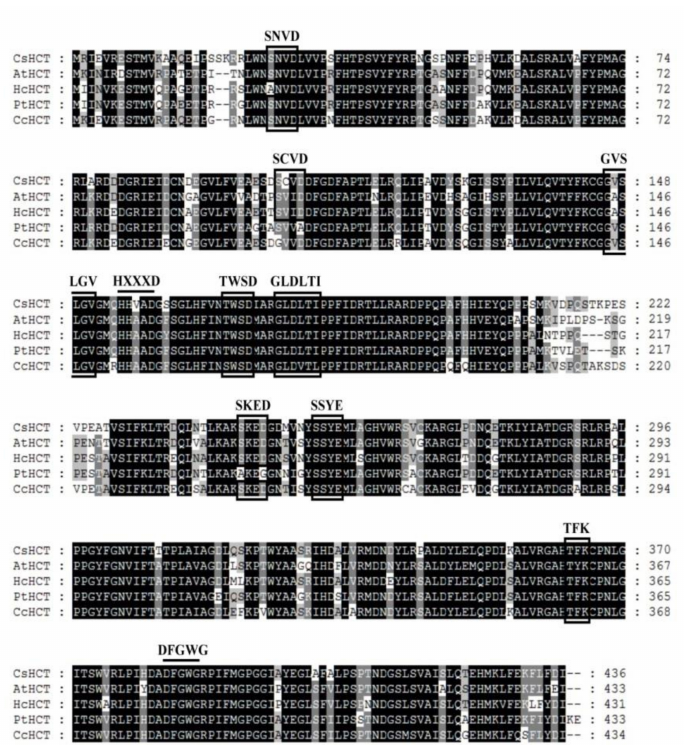
Figure 1. Alignment of deduced amino acid sequences of CsHCT with other putative HCTs. Black and gray shadings indicate conservation of 100% and at least 80%, respectively. Amino acid residues enclosed by squares correspond to consensus sequences of SXXD, SXXE, HXXXD, GVXXGV, TXXD, GLXXTI, DFGWG, etc. AtHCT, hydroxycinnamoyl-CoA shikimate/quinate hydroxycinnamoyl transferase was